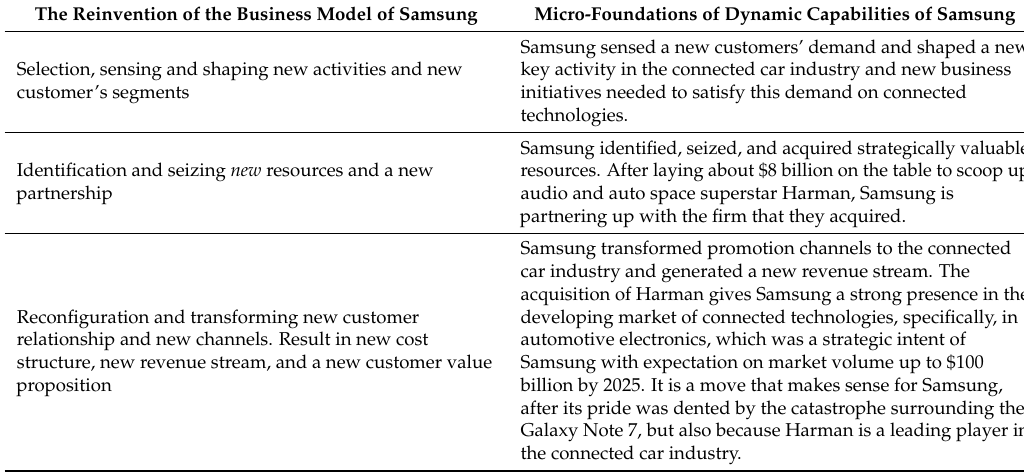
Table 4. Bridging perspectives together: the reinvention of Samsung business model (BM) acquiring Harman and micro-foundations of dynamic capabilities underpinning a transformation of BM building